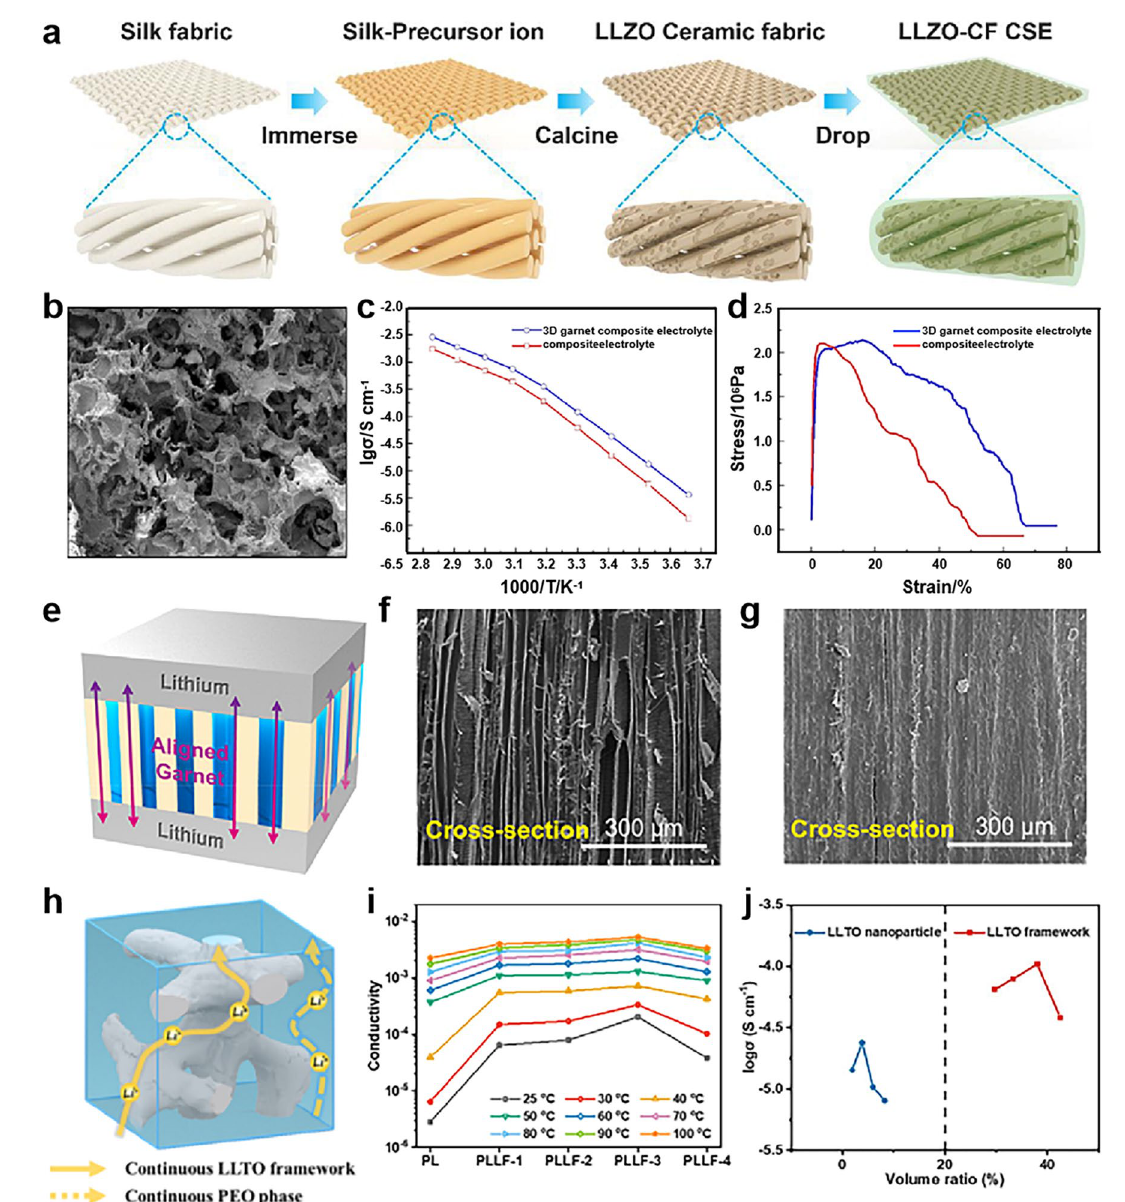
Fig. 4 a Schematic of the preparation of CSEs by the templating method. Reproduced with permission [127]. Copyright 2022, Elsevier. b SEM image of the garnet framework. c Arrhenius plots of the garnet/PEO CSEs. d Tensile test of the CSEs. b–d Reproduced with permission [101]. Copyright 2019, American Chemical Society. e Schematic of the Li symmetric cell with garnet-wood, showing the low tortuosity and fast lith- ium conduction pathways. SEM images of f pristine wood and g compressed wood. e–g Reproduced with permission [129]. Copyright 2019, American Chemical Society. h Schematic representation of possible Li + conduction pathway inside the PLLF electrolyte. i Ionic conductivity of PLLF electrolytes at different temperatures as a function of LLTO framework content. j The relationship between the volume ratio of inorganic components in the electrolyte and ionic conductivity at room temperature. h–j Reproduced with permission [133]. Copyright 2021,